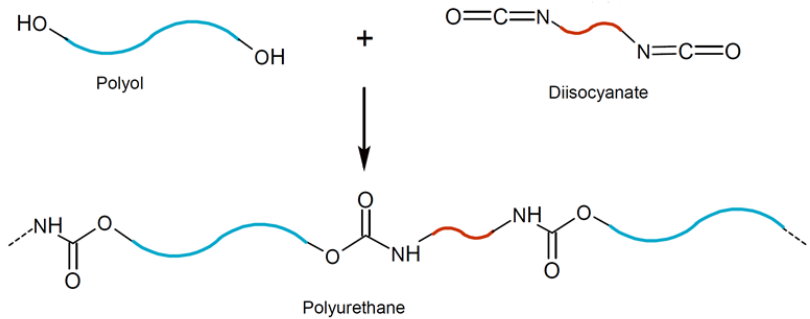
Figure 14. The reaction between polyol (blue) and diisocyanate (red) repeated units leading to the formation of PU.